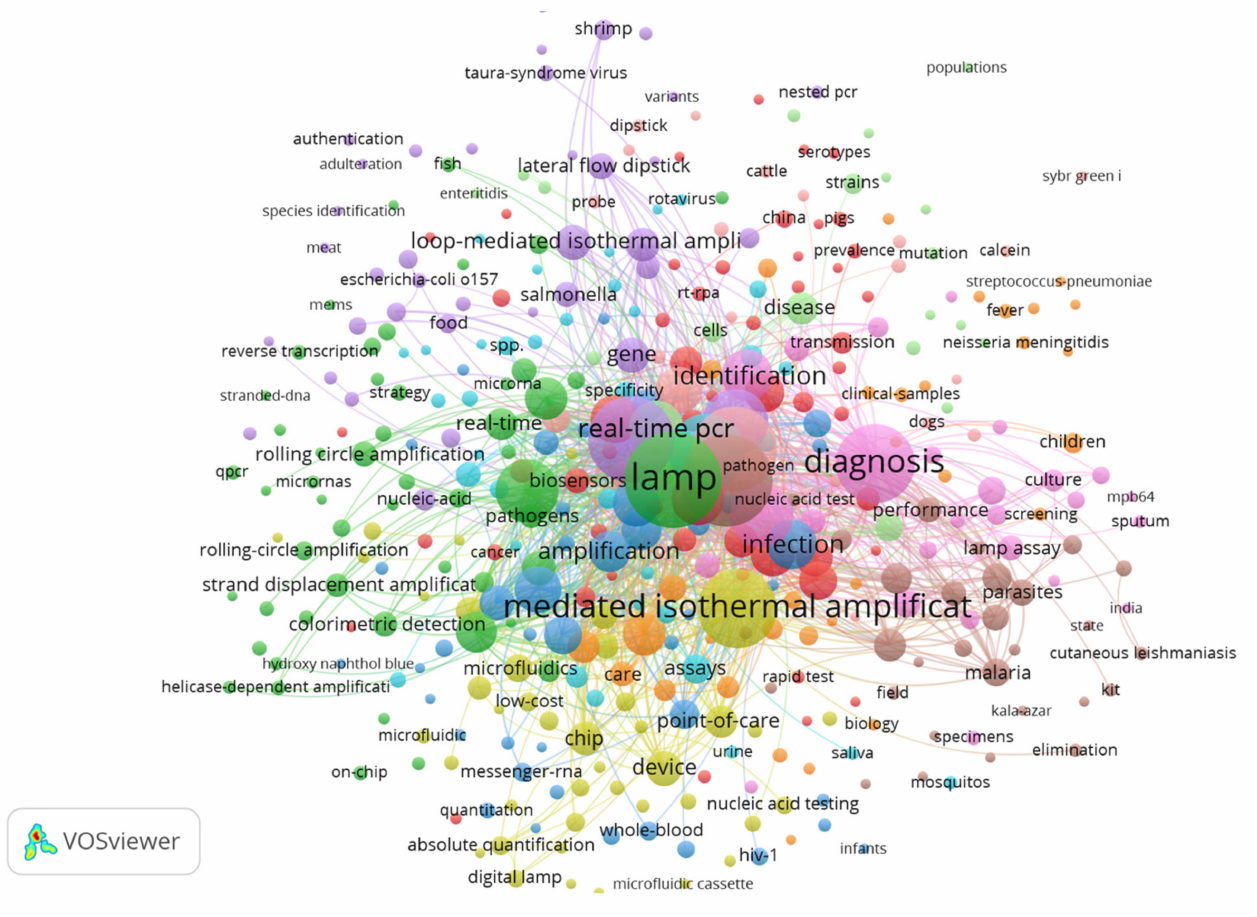
Figure 1. A VOS viewer overlay bibliographic coupling document cluster analysis of the “Isothermal